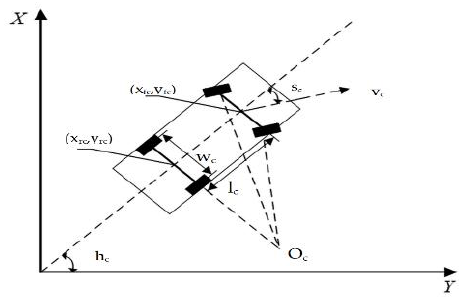
wheelbase of the vehicle, respectively. ordinate of the rear axle center, respectively; v c and l c are the moving speed and